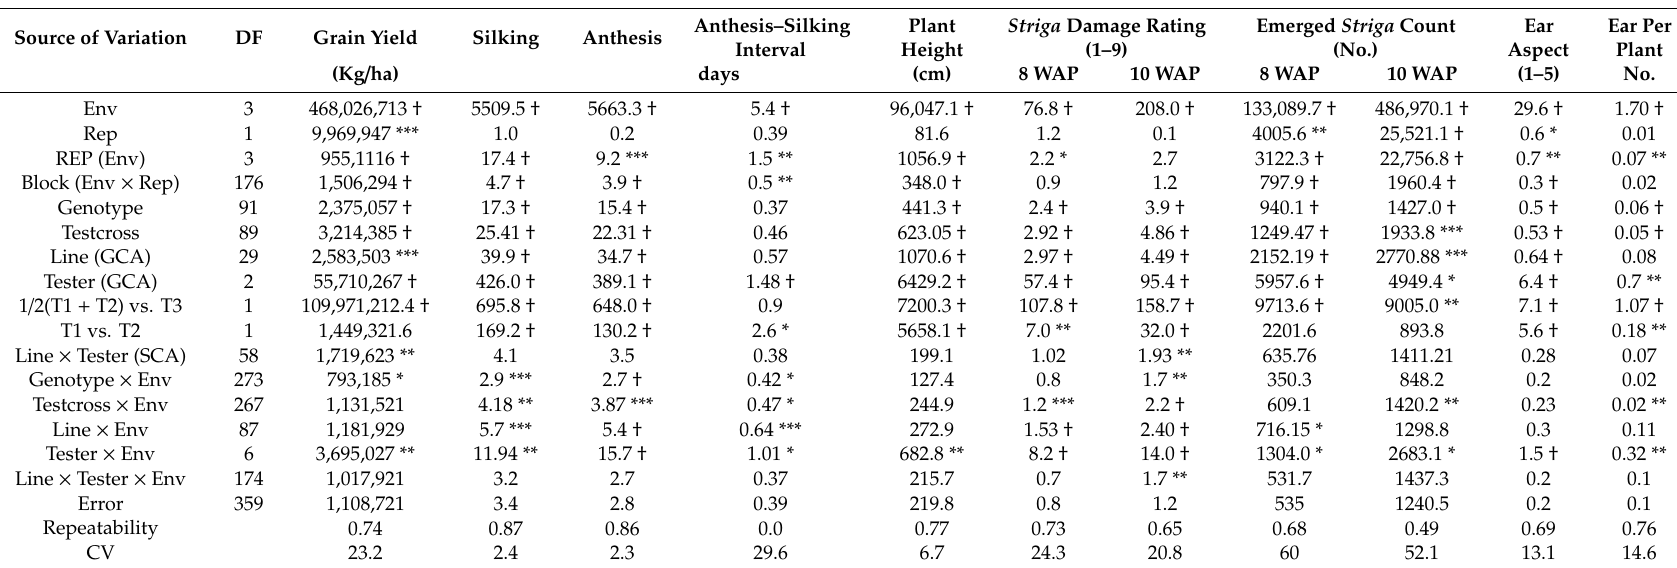
Table 1. Mean squares for grain yield and other traits of testcrosses of yellow maize inbred lines under the Striga -infested condition in four environments. Source of